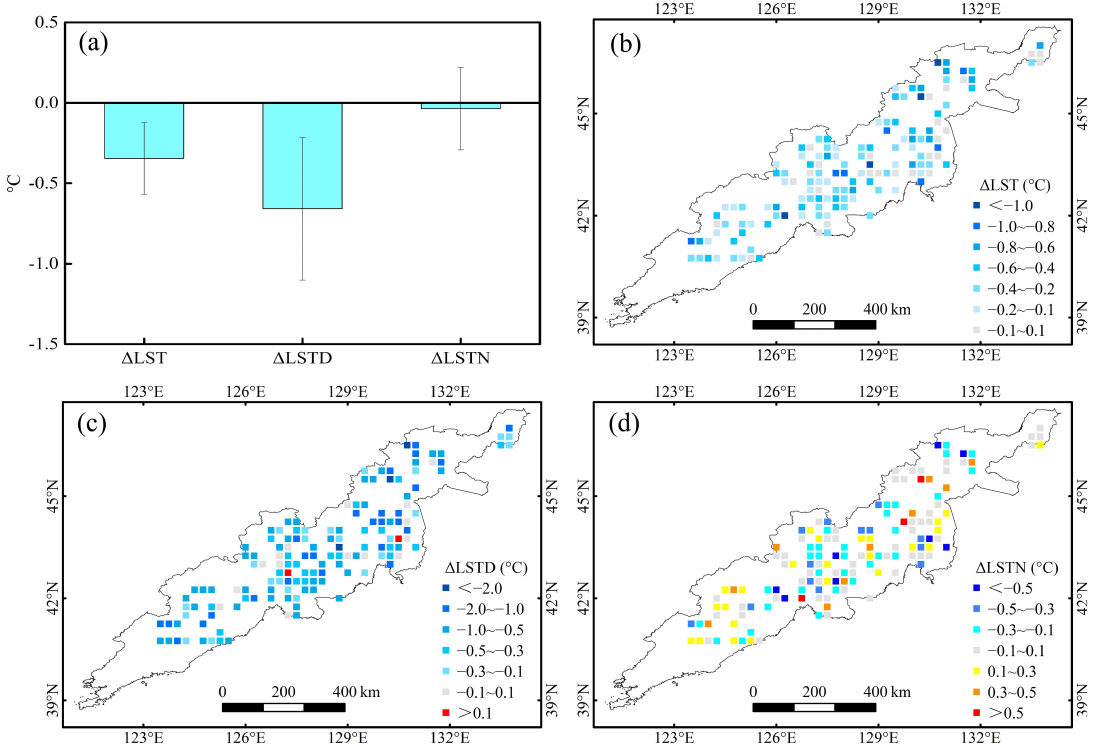
Figure 4. Regional average ( a ) and spatial distribution of differences in summer average surface temperature ( ∆ LST, ◦ C) ( b ), daytime surface temperature ( ∆ LSTD, ◦ C) ( c ), and nighttime surface temperature ( ∆ LSTN, ◦ C) ( d ) between high- and low-coverage forest in Changbai Mountain from 2003 to